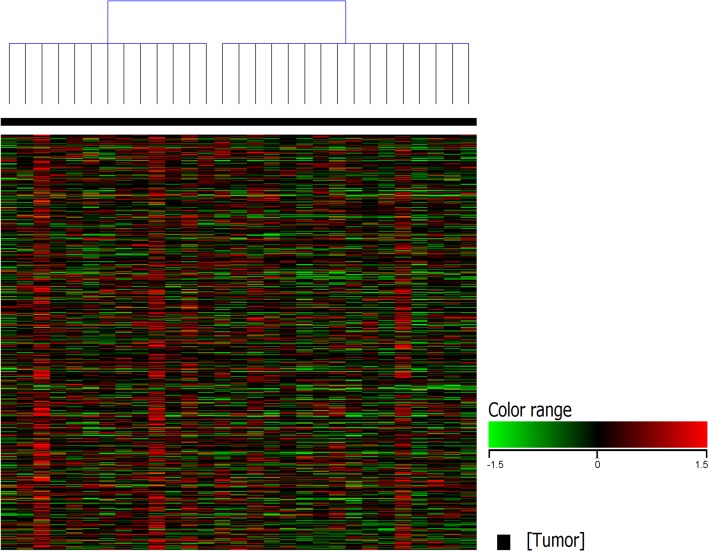
Unsupervised clustering of canine iUC samples separates tumor samples into two distinct groups.Canine iUC samples were normalized using TMM and DESeq concurrently. Statistical analyses were conducted using edge R (on TMM normalized data) and DESeq2 (on DESeq normalized data) with p corr ≤0.05. Only genes with ≥2 fold change were selected from each analysis, and the two lists of differentially expressed genes were combined. These differentially expressed genes were hierarchically clustered using K-means to result in unsupervised clustering of samples. The analyses revealed two distinct groups within the canine iUC tumor dataset (n = 13, n = 16).